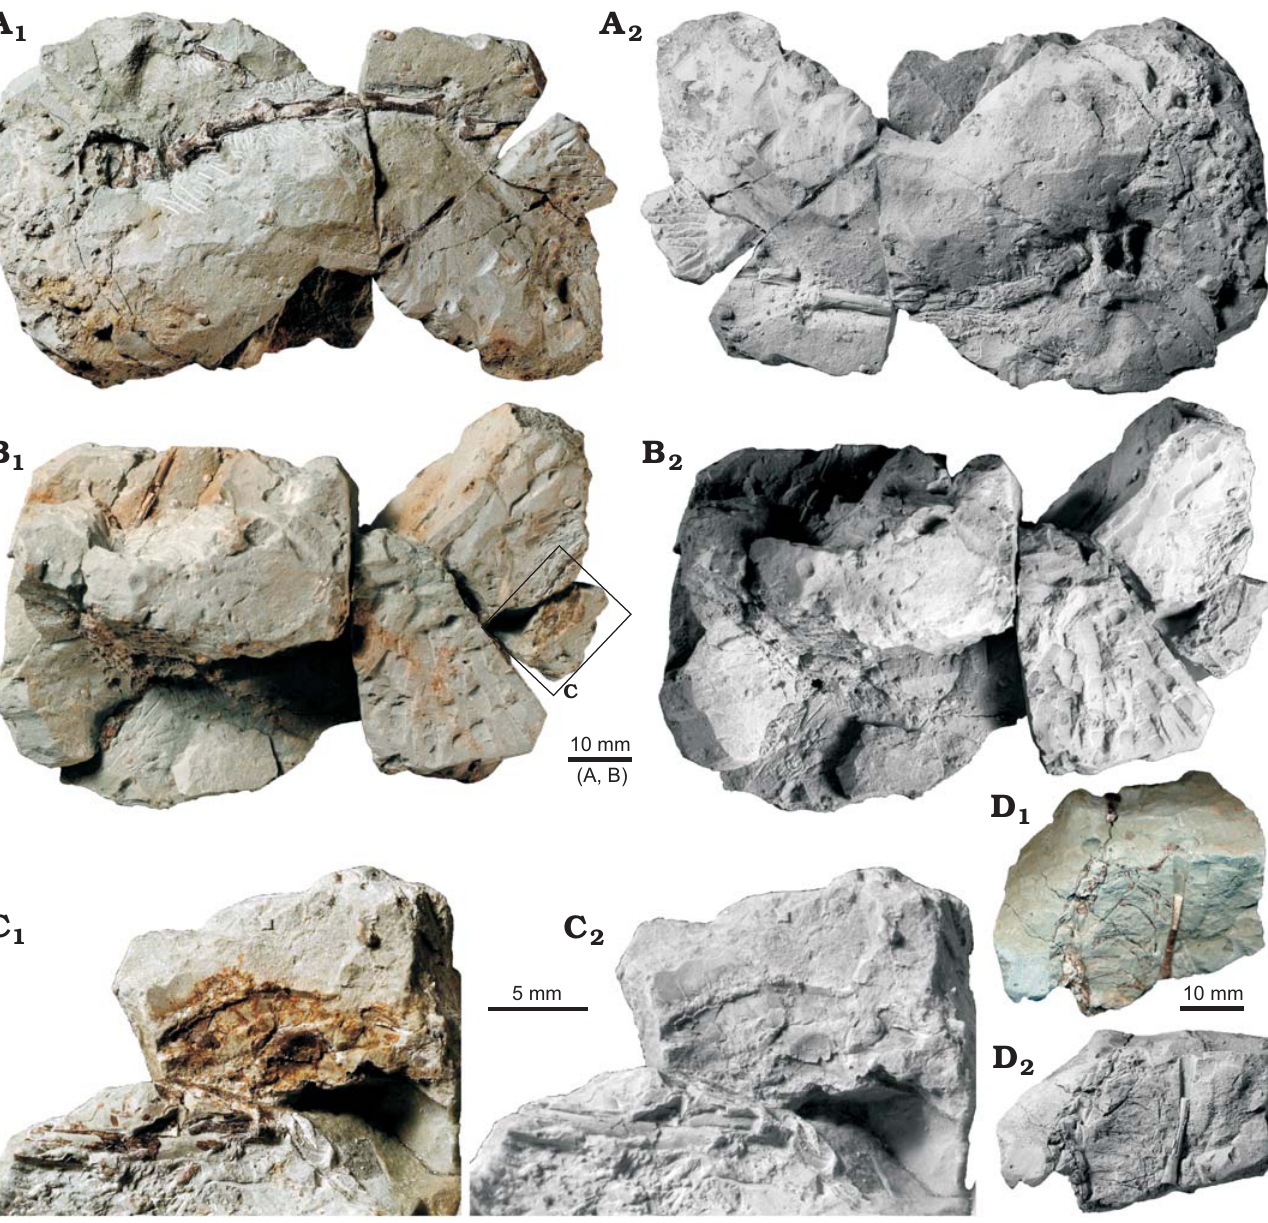
Fig. 3. Incomplete articulated skeleton ZPAL AbIII/2012 of long-necked reptile Ozimek volans gen. et sp. nov. from Krasiejów, lower Upper Triassic, preserved at a local sedimentary discontinuity surface between grey claystone and red fine-grained mudstone. View of the block from below ( A ) and above ( B ), showing location of the crushed skull; enlarged skull ( C ); part of the thorax ( D ), preserved in vertical orientation. Photographs of specimen whitened with ammonia chloride (A 2 –D 2 ). See also explanatory drawing (Fig.